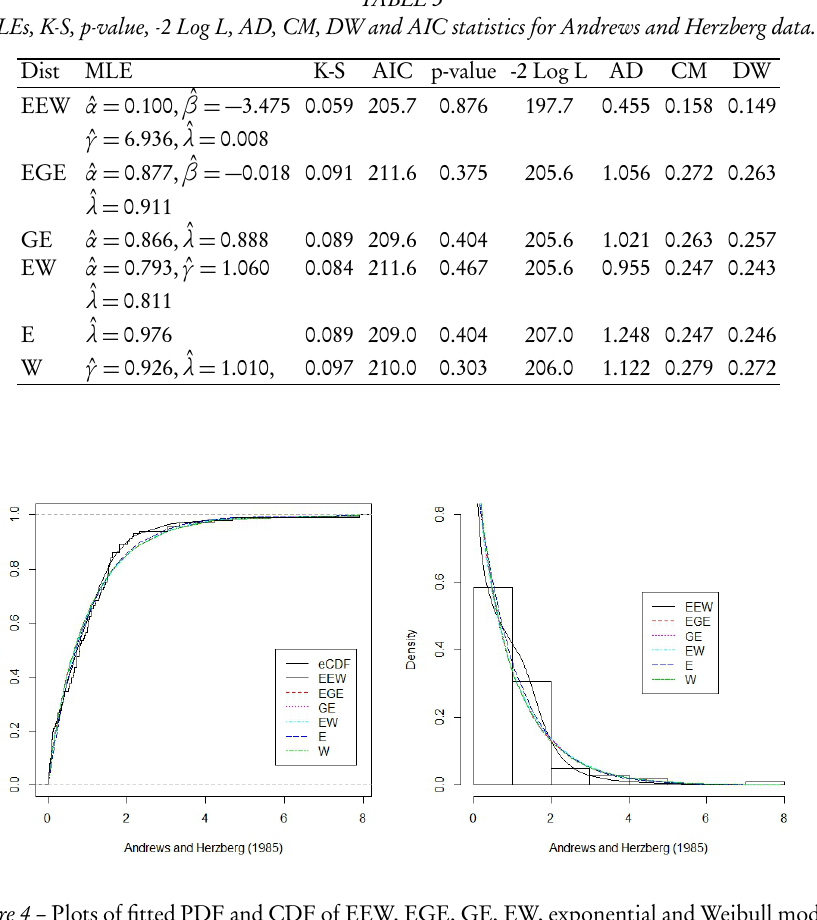
Figure 4 – Plots of fitted PDF and CDF of EEW, EGE, GE, EW, exponential and Weibull models for Andrews and Herzberg